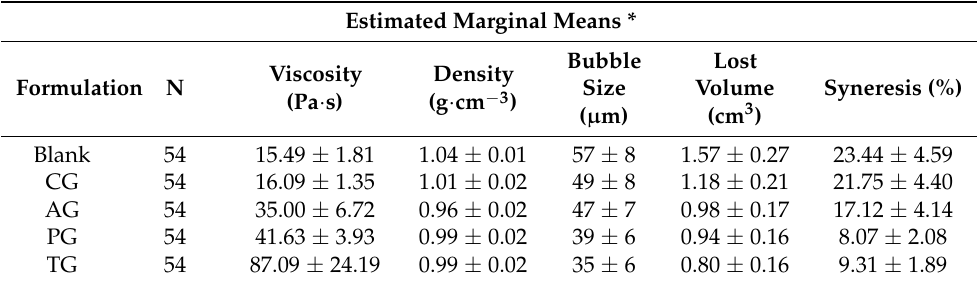
Table 3. Estimated marginal means evaluated in the Tukey